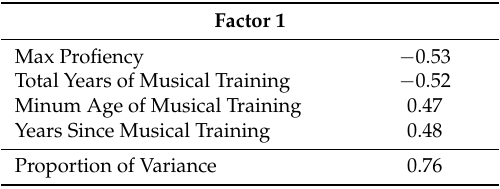
Table 8. PCA of the Musical Training Variables. The factor and factor loadings of the PCA computed over four musical training variables. The PCA yielded one factor that explained 76% of the total variance. Factor 1 had moderate-to-large loadings for all four musical training variables, suggesting that this factor served as a global musical training